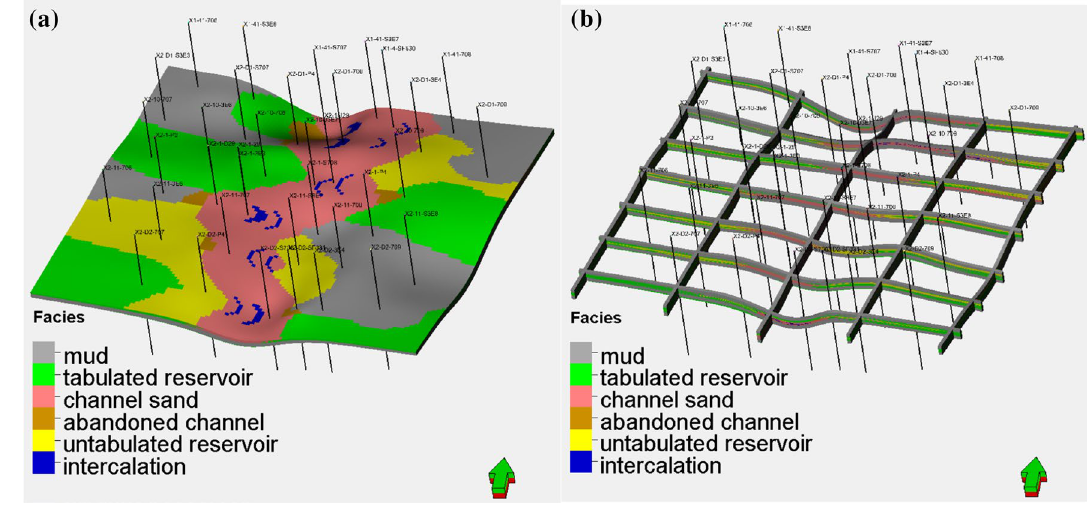
Fig. 6 Facies models in study area. a Facies model in study area; b facies fence model in study area